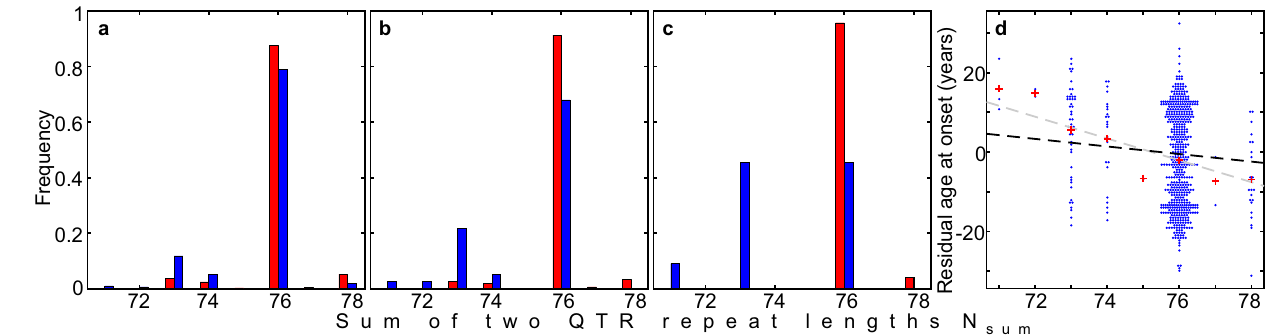
Fig. 3 The relationship between hexanucleotide quasi-tandem repeat (QTR) length and residual age at onset of HD. a – c Histograms showing distribution of the sum of two QTR repeat lengths N sum = N min + N max for the groups with early (red, R < − R thr ) and late (blue, R > R thr ) onsets. Panels ( a , b , and c ) correspond to the residual age at onset threshold R thr of 0, 13, and 20 years, respectively. d Association of the sum of two QTR repeat lengths N sum with the residual age at onset for the entire HD cohort. Red pluses indicate mean residual age at onset for every sum of QTR repeat lengths. Grey and black dashed lines are plotted using coef fi cients of the linear regression analysis and regression with selection.